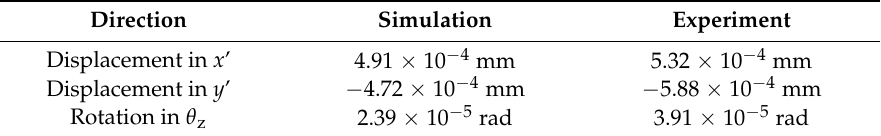
Table 7. Comparison results between the simulation and emulation with multi-objective optimized kinematics